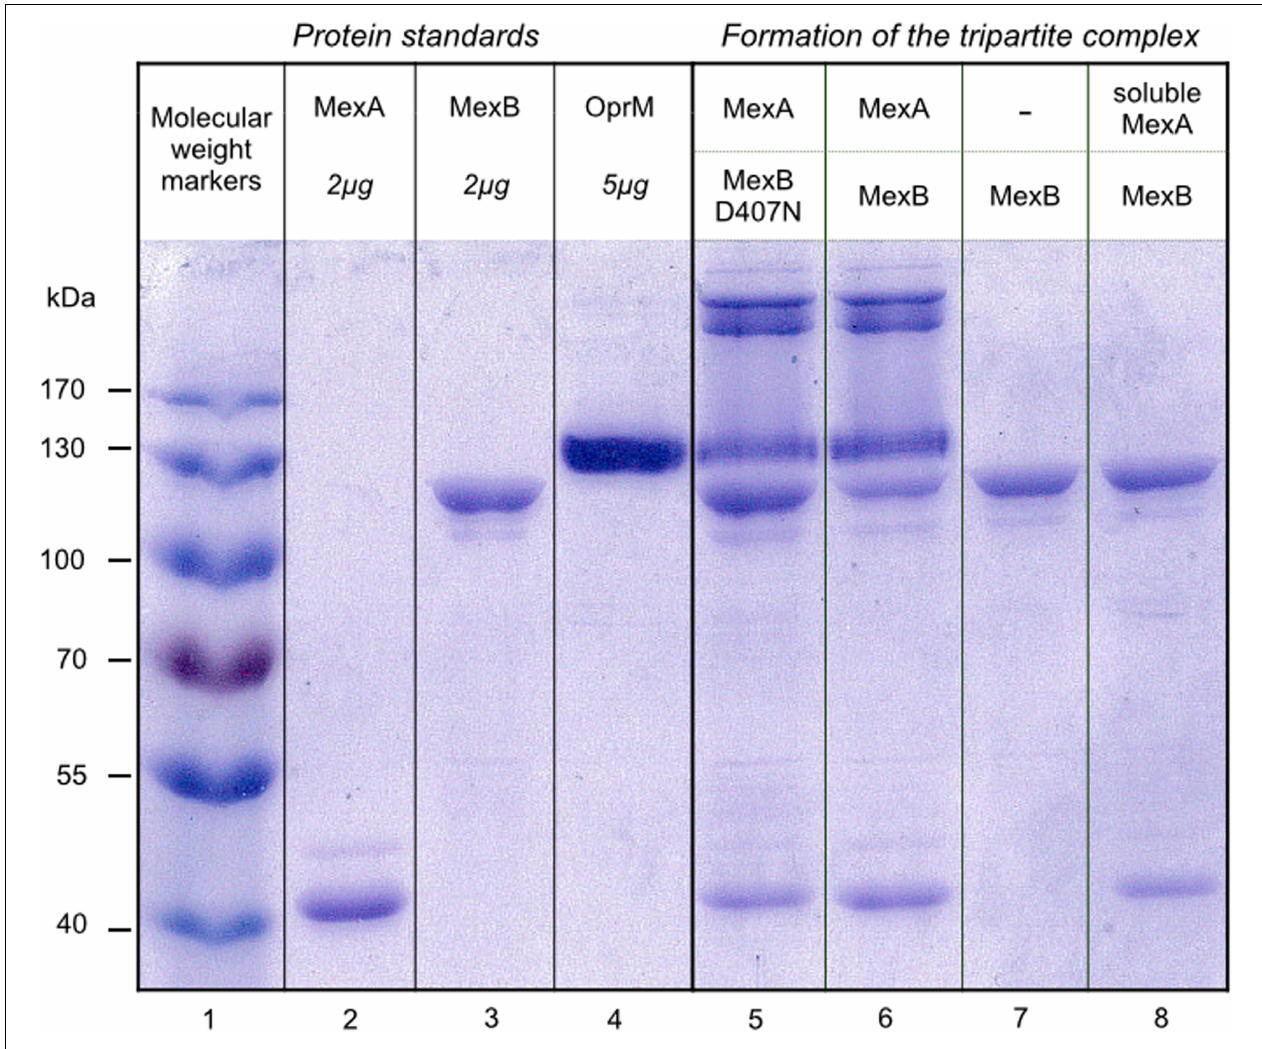
FIGURE 1 | MagStrep-mediated pulldown of proteoliposomes allows for an identification of the formation tripartite complexes. Lane 1 contains molecular mass markers (PageRuler Prestained Protein Ladder from Thermo Scientific, #26616). Detergent-purified MexA, MexB, OprM are loaded (2–5 µ g protein per lane) onto a 10% SDS-PAGE Laemmli gel as reference (lanes 2, 3, and 4, respectively) and stained with Coomassie Blue. Proteoliposomes